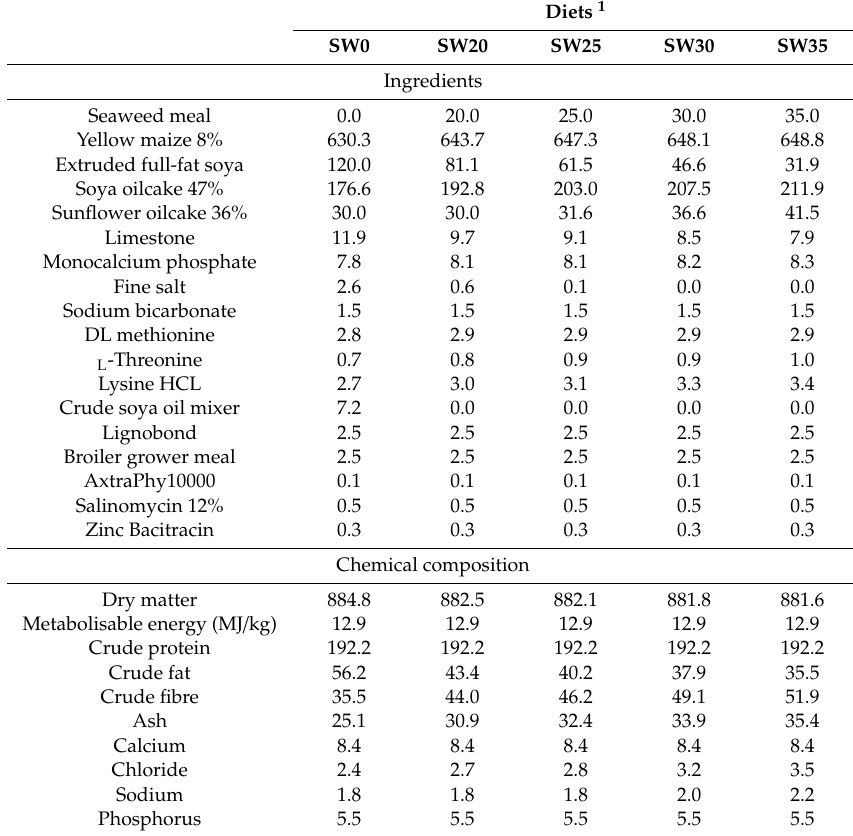
Table 1. Ingredients and chemical composition (g / kg as-fed basis, unless stated otherwise) of diets containing seaweed